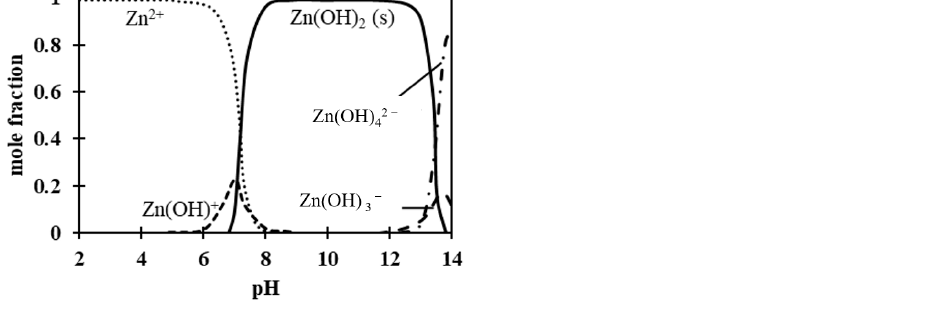
Figure A6. Dependences of Zn(II) forms on the pH value of the aqueous solutions (c 0 = 2 mmol dm − 3 ).